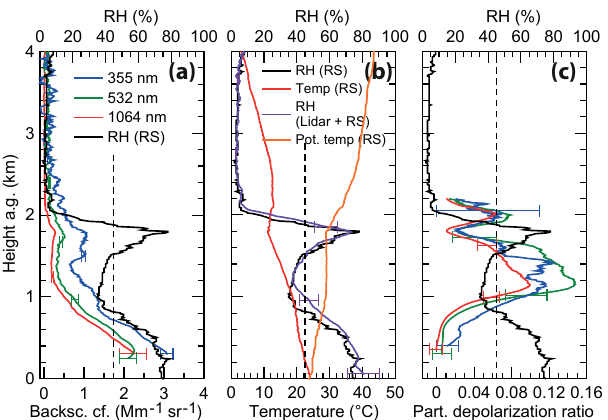
Figure 9. Thirty-minute mean profiles of particle backscatter coef- ficient (a) and particle linear depolarization ratio (c) at three wave- lengths together with radiosonde RH (indicating the MAL up to 2km height). The lidar observation was performed on 23 February 2014, 19:45–20:15 local time (23:45–00:15UTC). The atmospheric variability was low during the signal averaging period (Fig. 4). Panel (b) shows the potential temperature ( T pot , radiosonde, launch at 00:00UTC) and RH from radiosonde and from lidar (30min av- erage). Note the sharp drop in RH from > 70% (at 1850m height) to < 10% (at 2100m height). The dashed line marks the sea salt efflorescence point (45% RH). Error bars indicate the lidar retrieval uncertainty. The vertical smoothing window length is 50m for the backscatter and RH (lidar) and 100m for the depolarization ratio.